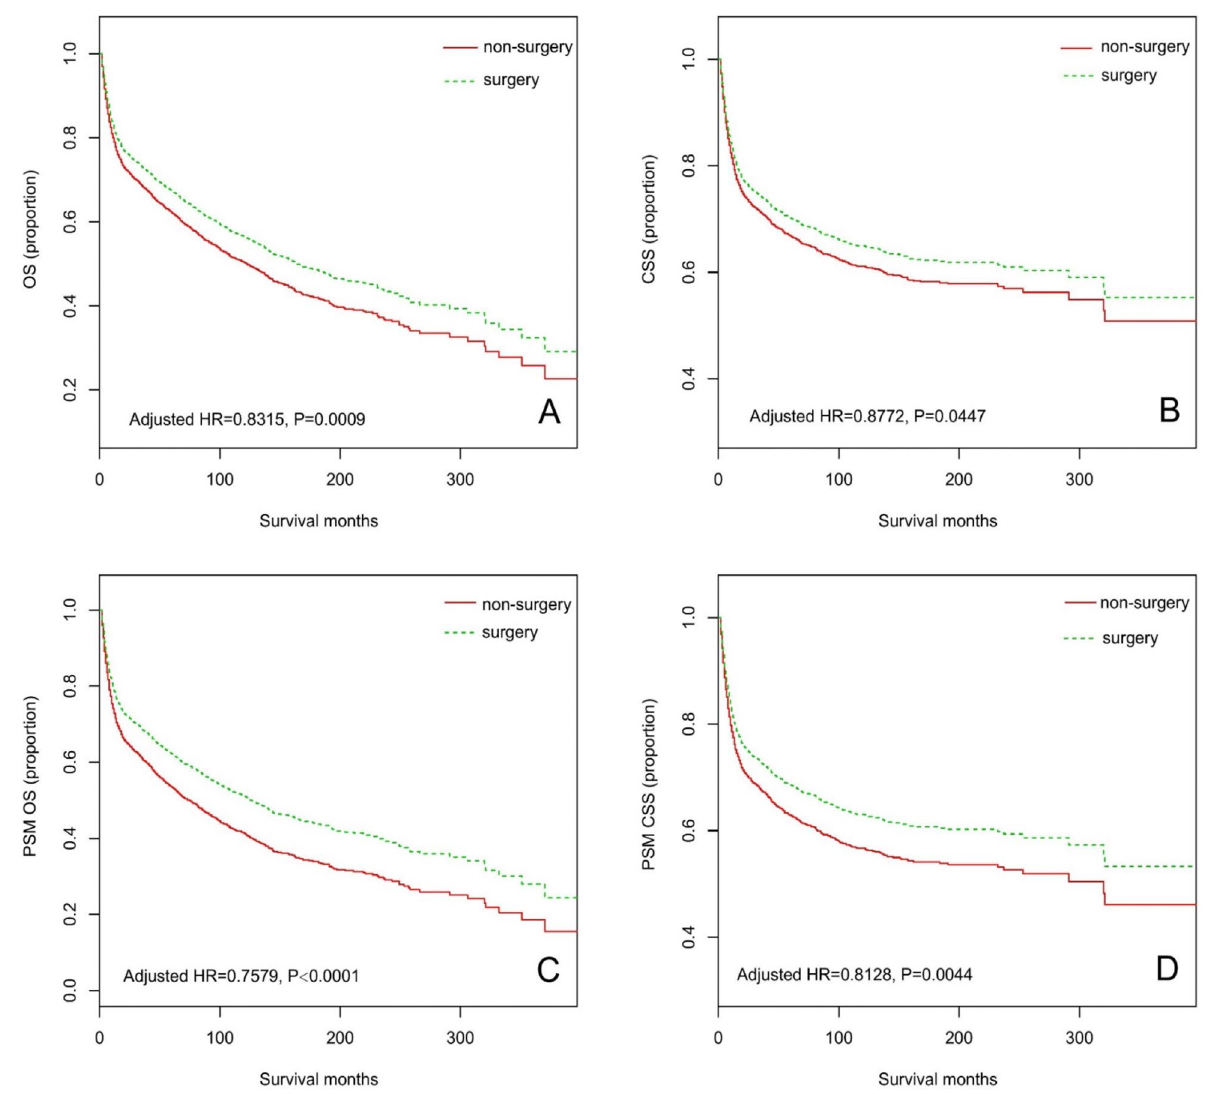
Figure 2. Kaplan–Meier curves for ( A ) overall survival (OS) and ( B ) cancer specific survival (CSS), for ( C ) propensity score-matching (PSM) OS and ( D ) PSM CSS. Adjusted HR was calculated based on the Cox proportional hazard model with adjustment of age, gender, race, marital status, year of diagnosis, Ann Arbor stage, histologic, tumor site and radiation in Figure ( A,B ). Figure ( C ) of OS adjusting for age, year of diagnosis, Ann Arbor stage, histologic and tumor site. Figure ( D ) of CSS adjusting for age, gender, marital status, year of diagnosis, Ann Arbor stage, histologic, tumor site and